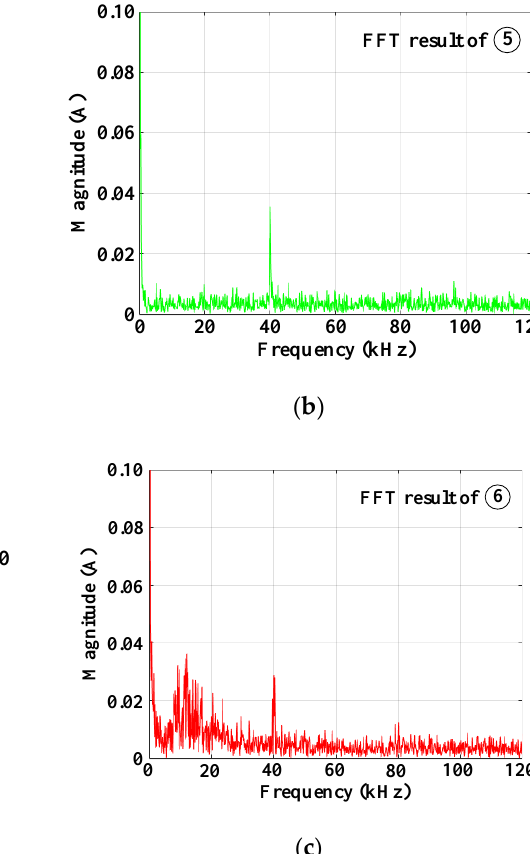
Figure 9. Current waveform and FFT results of 𝐼 𝑎𝑟𝑐3 when the magnitude of current is 5 A and switching frequency is 20 kHz: ( a ) current waveform, ( b ) FFT result before arcing, and ( c ) FFT result after arcing.